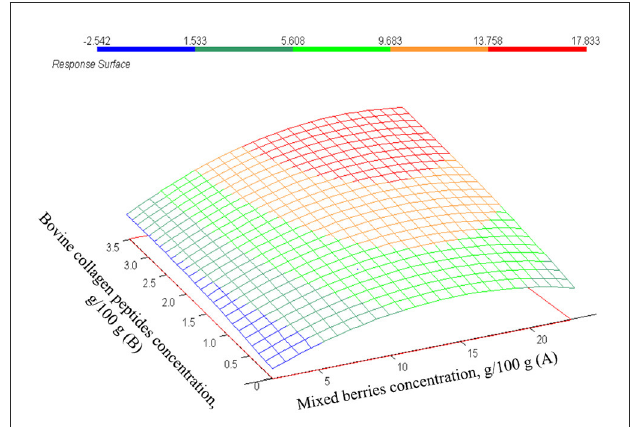
FIGURE4 The estimated values of total anthocyanin concentration. mg/L in function of mixed berries concentration (A) and bovine collagen peptides concentration